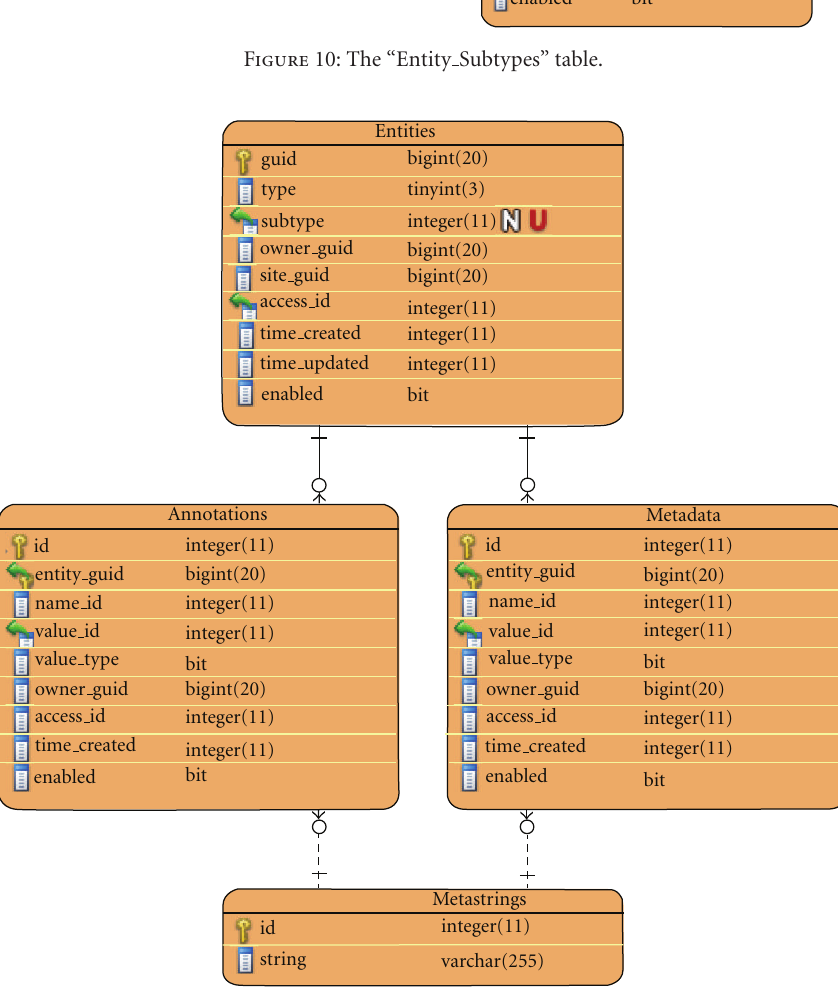
Figure 11: The tables “Annotations,” “Metadata,” and